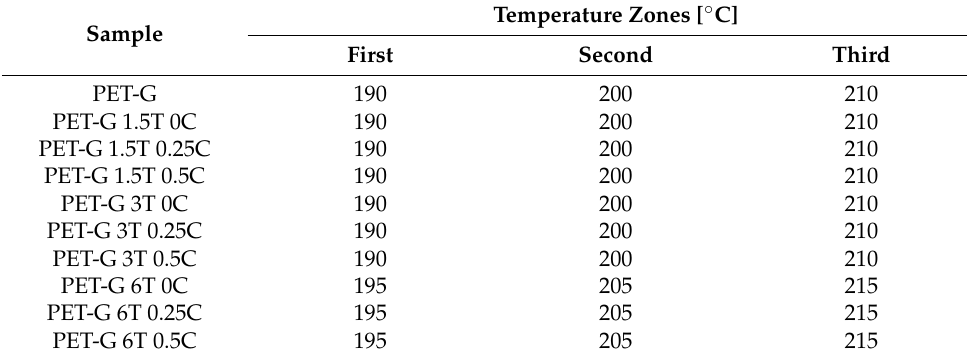
Table 2. Defined temperature zones for the twin-screw